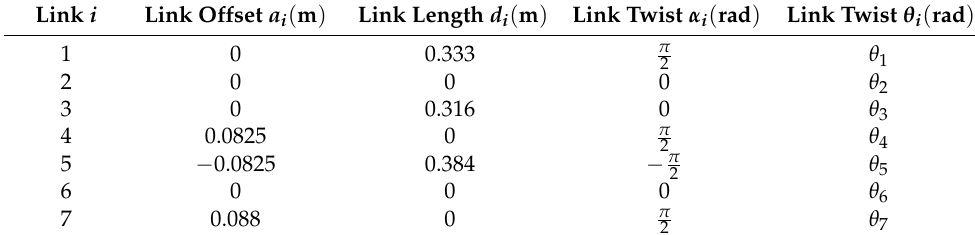
Table 3. D-H parameters.